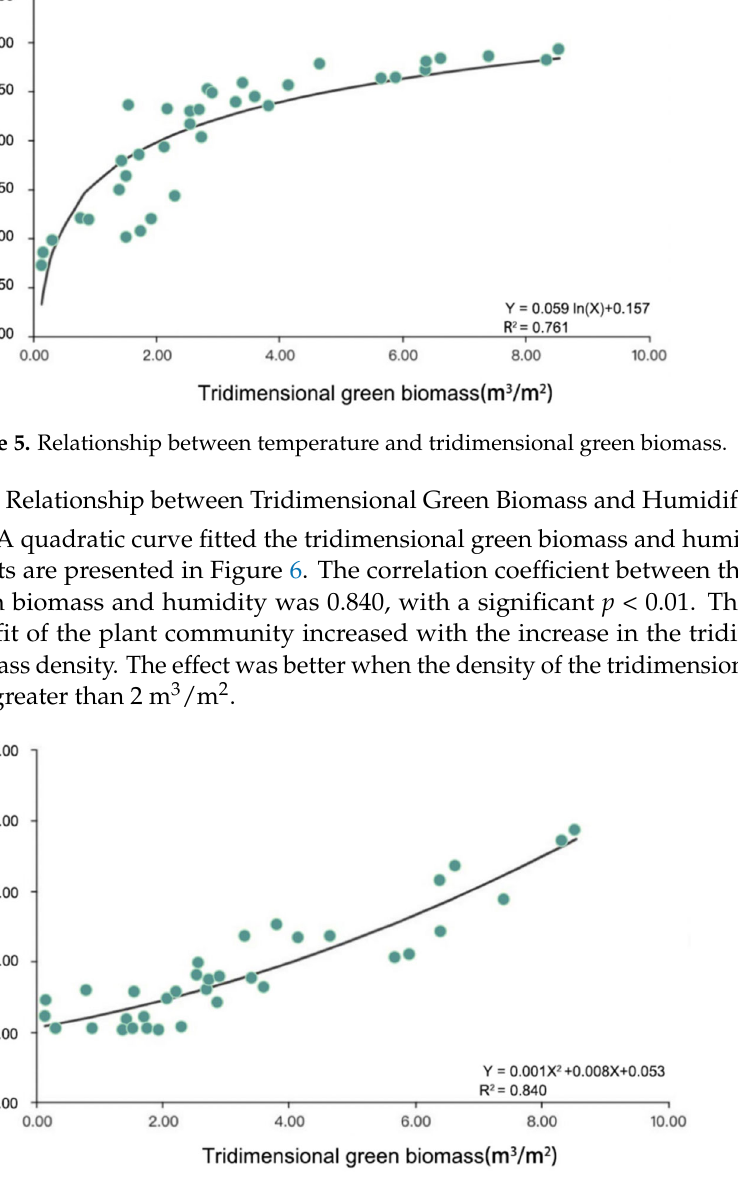
Figure 7. Relationship between discomfort index and canopy density. 3.3.2. The Relationship between Discomfort and Tridimensional Green Biomass Using a scatter plot, a quadratic curve fitting was performed between the discomfort index and tridimensional green biomass to explore their relationship. As shown in Figure 8, the discomfort index first decreased and then increased with the increase in plant tridi ‐ mensional green biomass. The discomfort index was relatively low when the density of the tridimensional green biomass was 4–6 m 3 /m 2 , which provides an answer for research question 2 (RQ2).